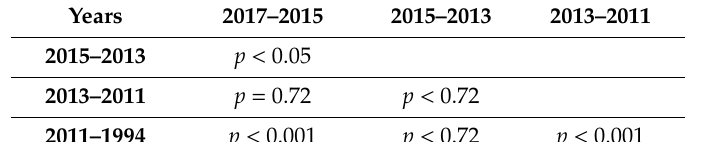
Table 4. Wilcoxon rank sum test between annual panne change rates.